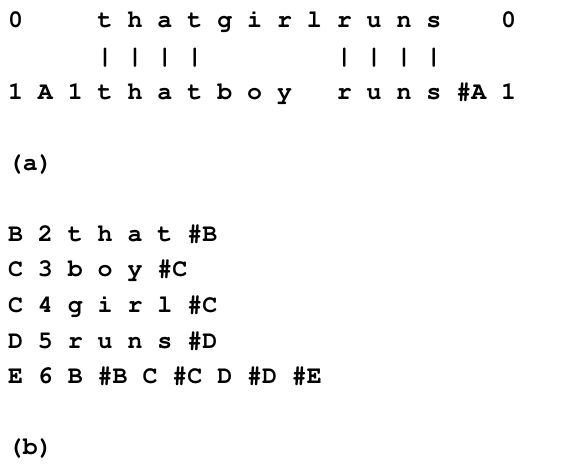
Figure 8. ( a ) A simple multiple alignment from which, in the SP model, Old patterns may be derived; ( b ) Old patterns derived from the multiple alignment shown in ( a